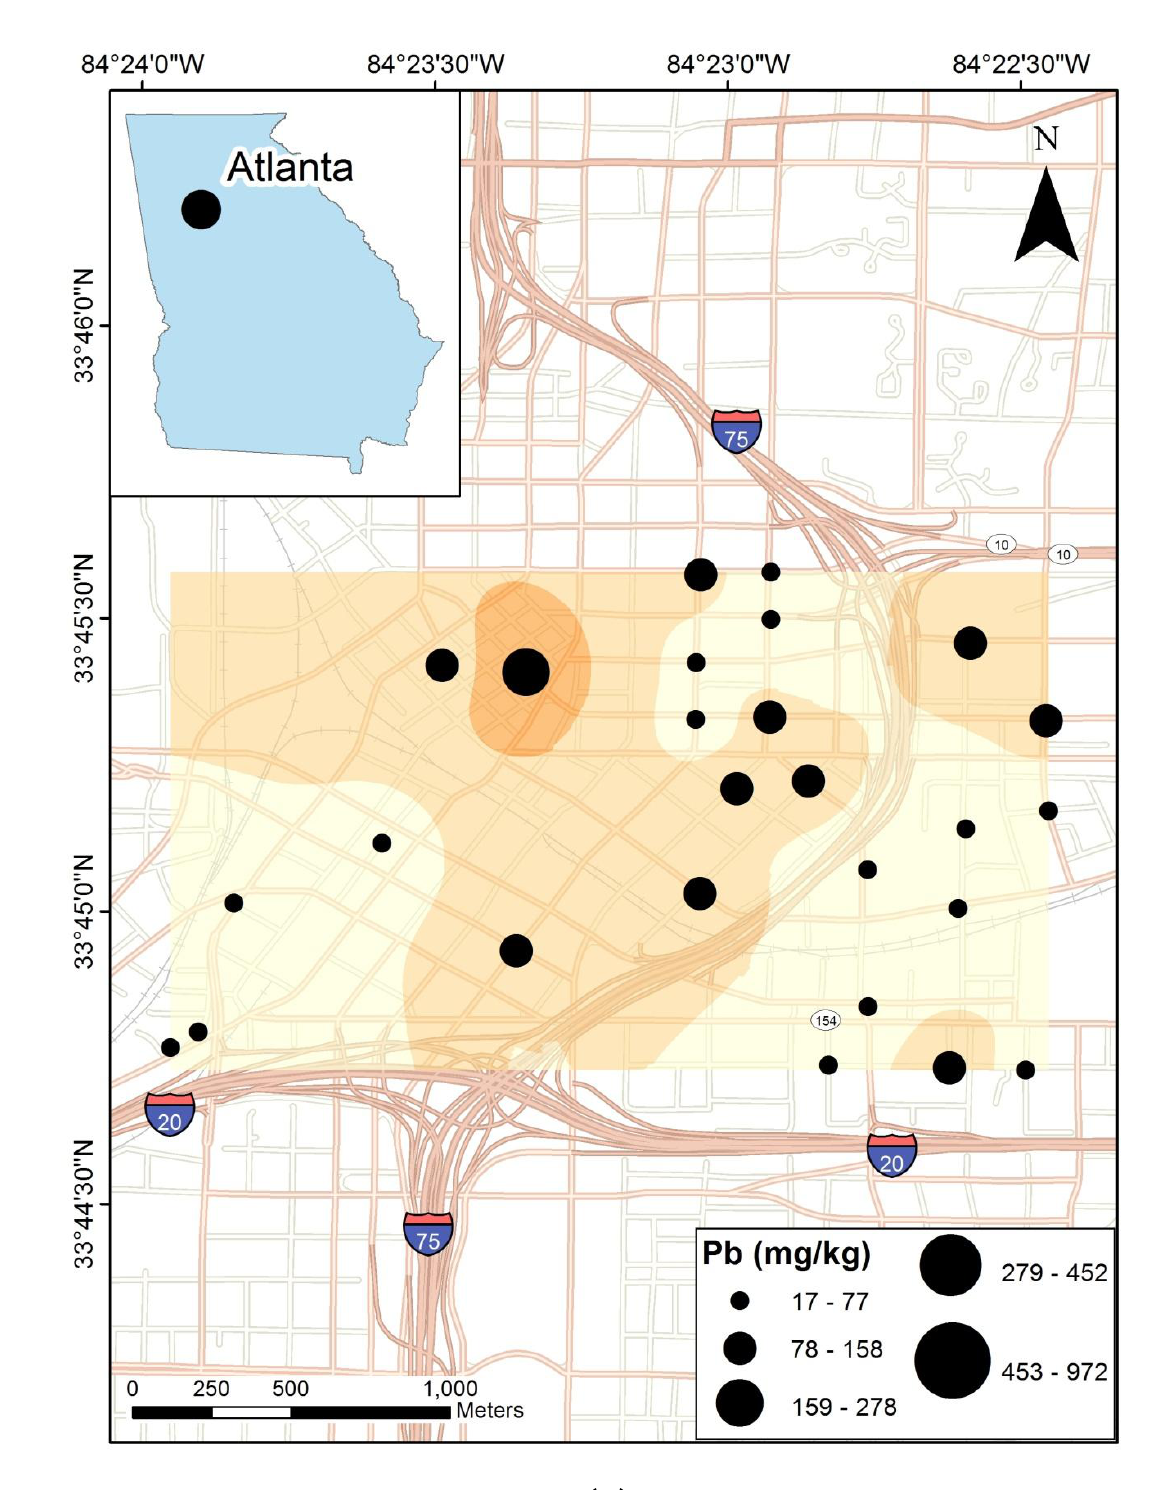
Figure 1. Maps of road dust Pb concentrations and interpolated prediction values in ( A ) Downtown Atlanta, and ( B ) Neighborhood Planning Unit V